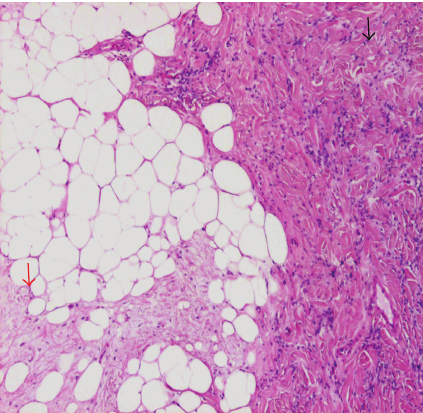
Figure 1: Mammary myofibroblastoma (MFB) with admixed but distinct spindle cell lipoma component. MFB component (black arrow) shows clusters of bland ovoid/spindle or epithelioid cells set in a dense fibrous stroma and spindle cell lipoma component (red arrow) (H&E ( × 200)).